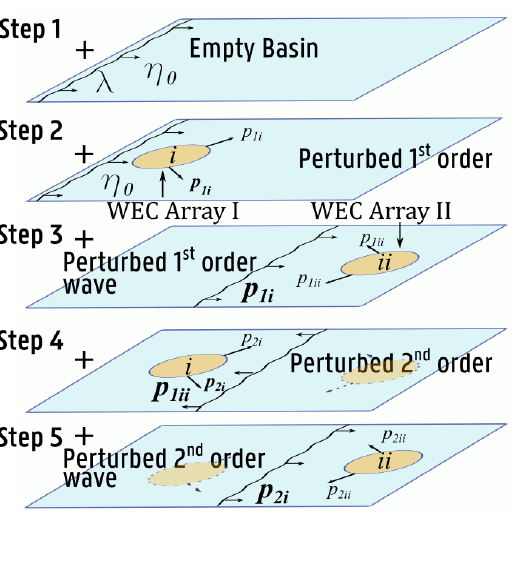
Figure 12. Step by step procedure for determining the perturbed field for regular incident wave propagating from the left